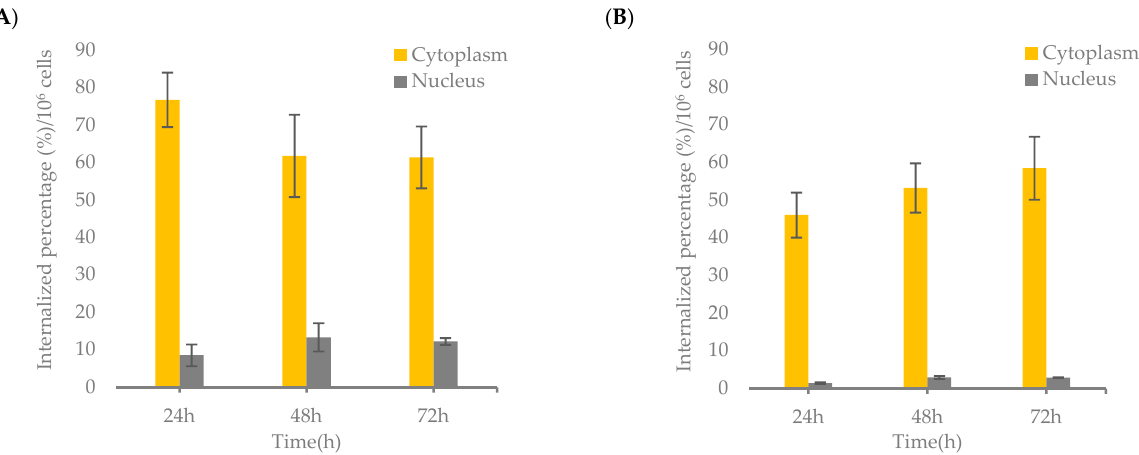
Figure 6. Subcellular accumulation of [ 64 Cu]Cu-NOTA C3-TP with high AMA in ( A ) HCT116 cells and ( B ) GM05757 normal fibroblast as function of incubation time. Data are presented as the percentage of total activity (%)/10 6 cells.